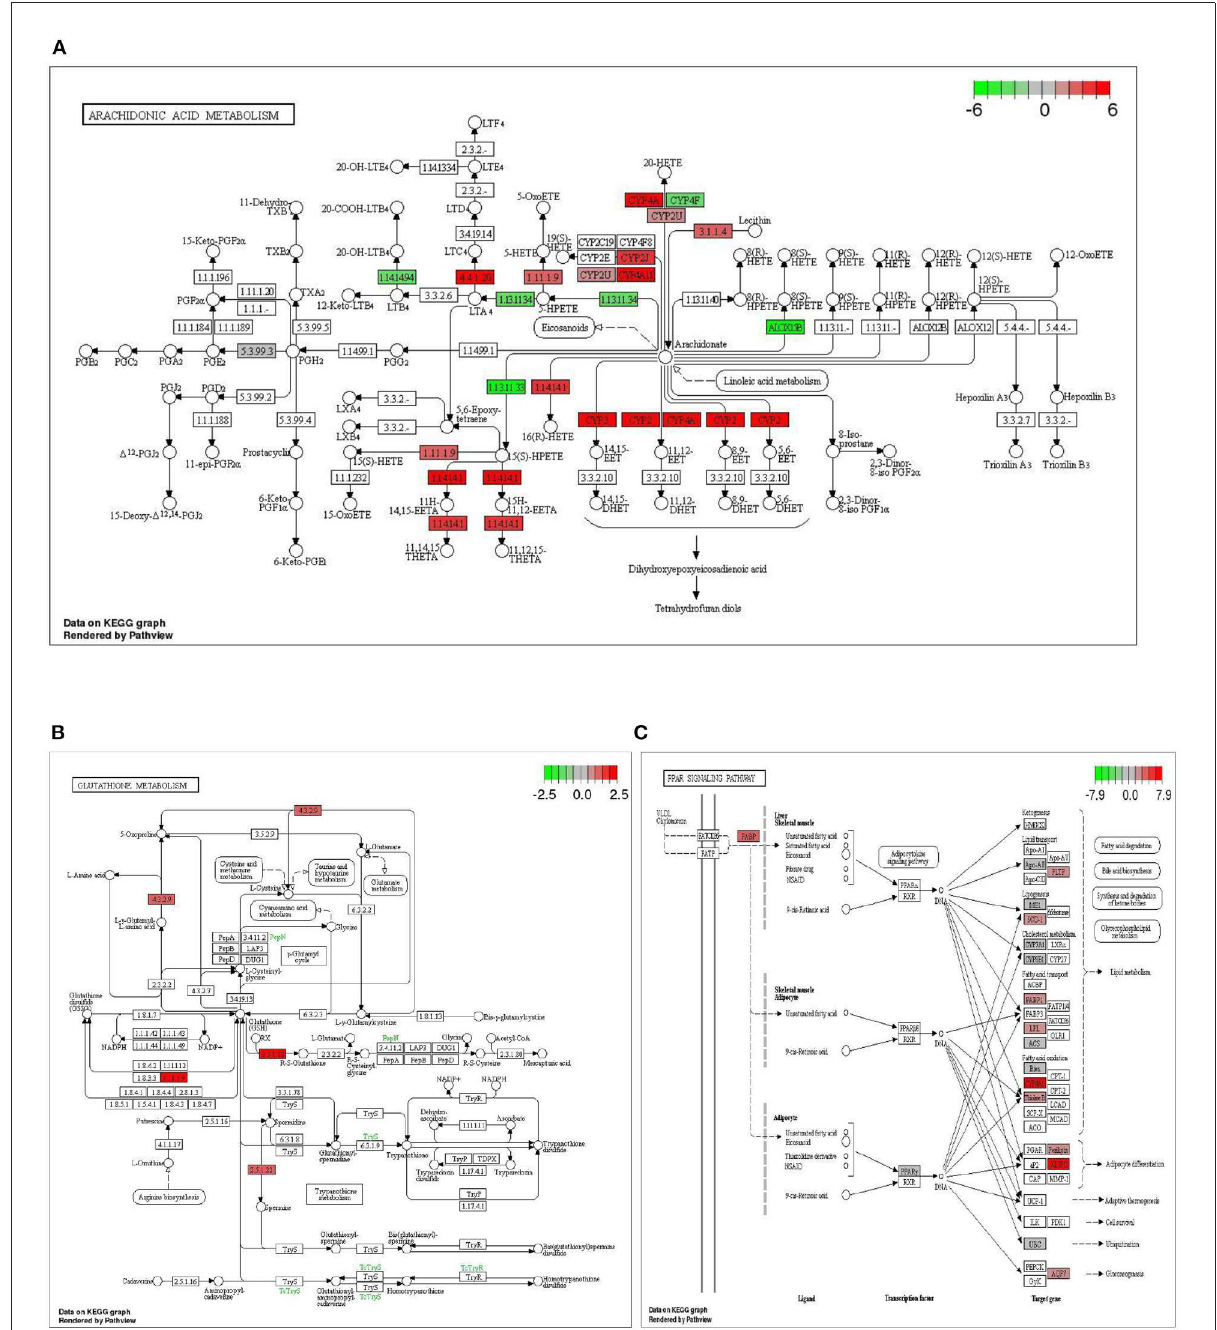
FIGURE7 Significantly enriched signaling pathway by DTE. (A) Effect of DTE on Arachidonic acid metabolism pathway; (B) Effect of DTE on Glutathione metabolism pathway; (C) Effect of DTE on PPAR signaling pathway.